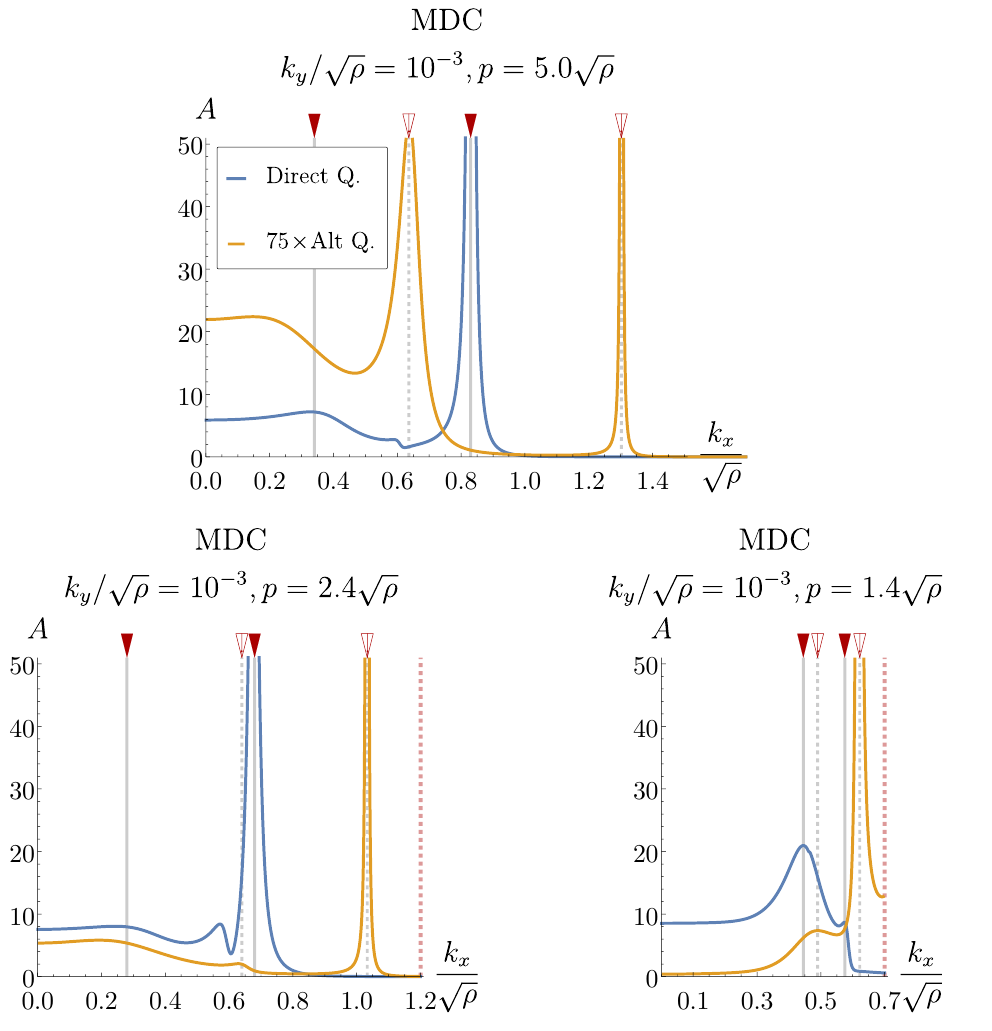
Figure 9 . Momentum distribution curves in strong unidirectional holographic lattices ( (cid:21) = 8 : 0 ) in direct and alternate quantizations. At large lattice momentum, when the BZ boundary is far away from the FS, the the peaks in direct and alternate quantization alternate along the MDCs (cf. (cid:12)gure 3). The positions of Direct Q peaks and Alt Q dips are correlated. When the BZ boundary is brought closer, the peaks and zeroes seem to absorb each other. For p = 1 : 4 peak is eaten by the zero